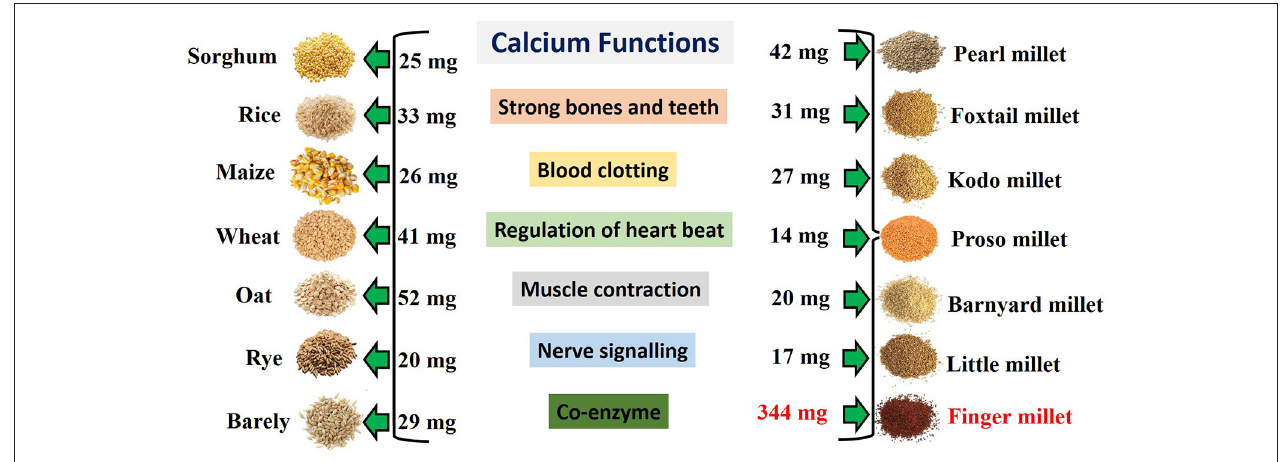
FIGURE 1 | Calcium (Ca) content of various cereals. The Ca content of finger millet and other major cereals and small millets are presented for strengthening the human health. The given Ca content is expressed per 100g of seeds for all cereals including finger millet. Ca content data of all cereals were collected from Shobana et al. (2013), Saleh et al. (2013), and McKevith